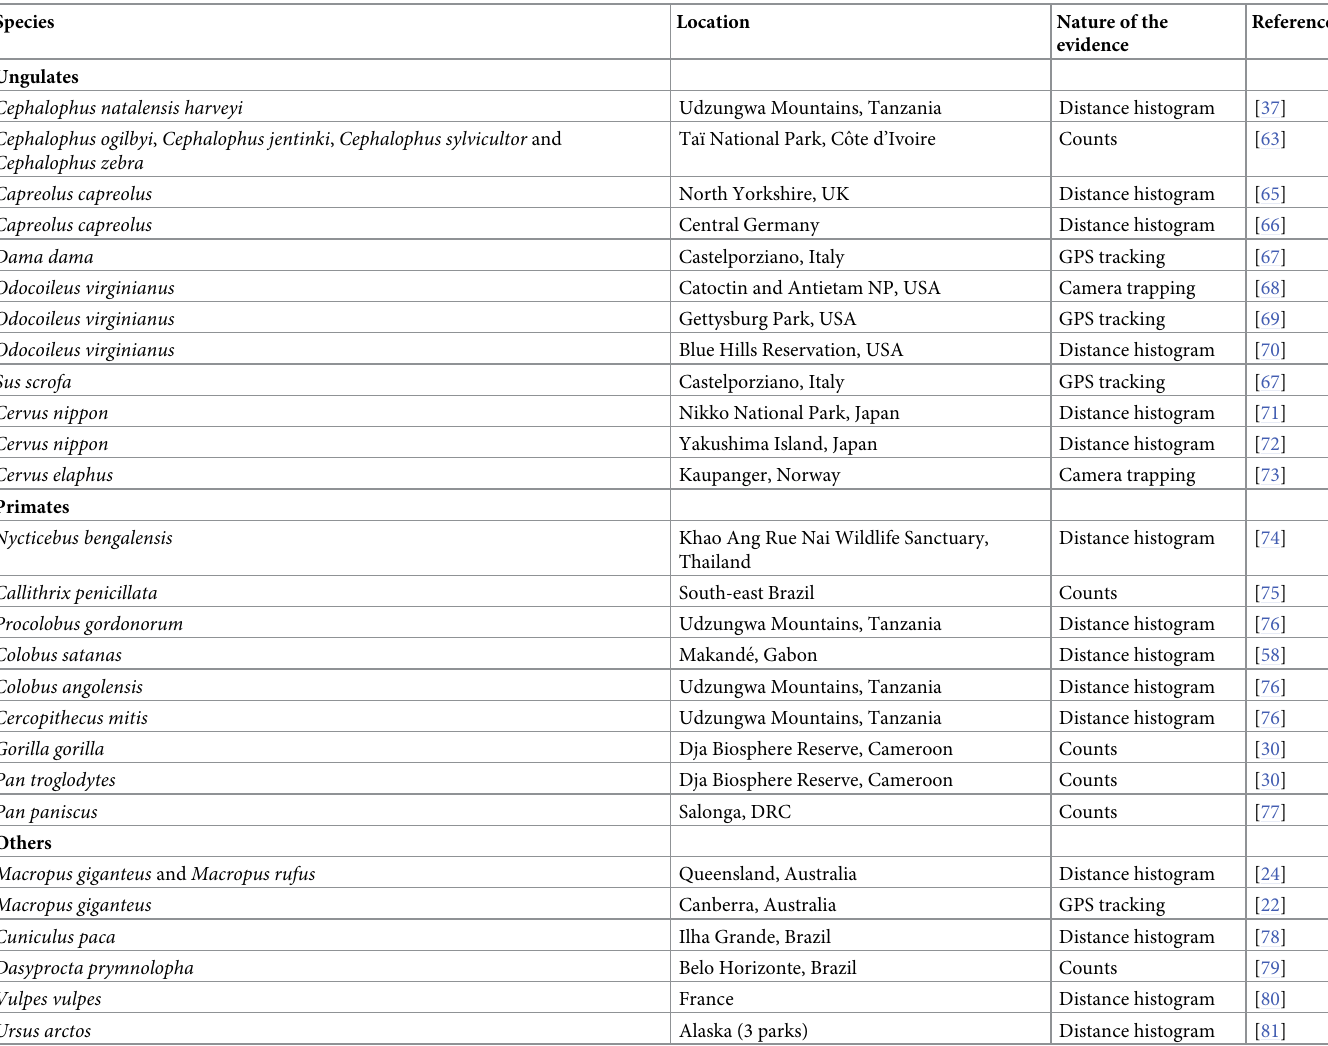
Table 1. A non-exhaustive review of studies evidencing a behavioural response to the transects in forest- or woodland-dwelling mammals. We only compiled posi- tive reports of behavioural responses. “Distance histogram” means that the distribution of recorded distances followed a shape like in Fig 1, sometimes with additional evi- dence from further modelling. “GPS tracking” means that geo-tracked individuals avoided the vicinity of the transects more than expected by chance. “Camera trapping” means that the frequency of pictures decreased near transects. “Counts” means that population abundance was larger in a block without transect than in a block with